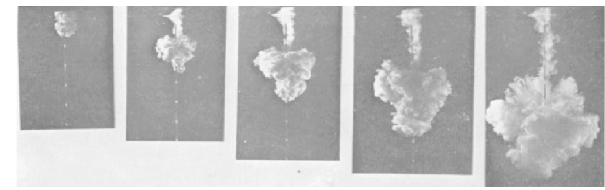
Figure 1. Example of the bubble experiment: photos of a sequence from left to right (reproduced from Scorer